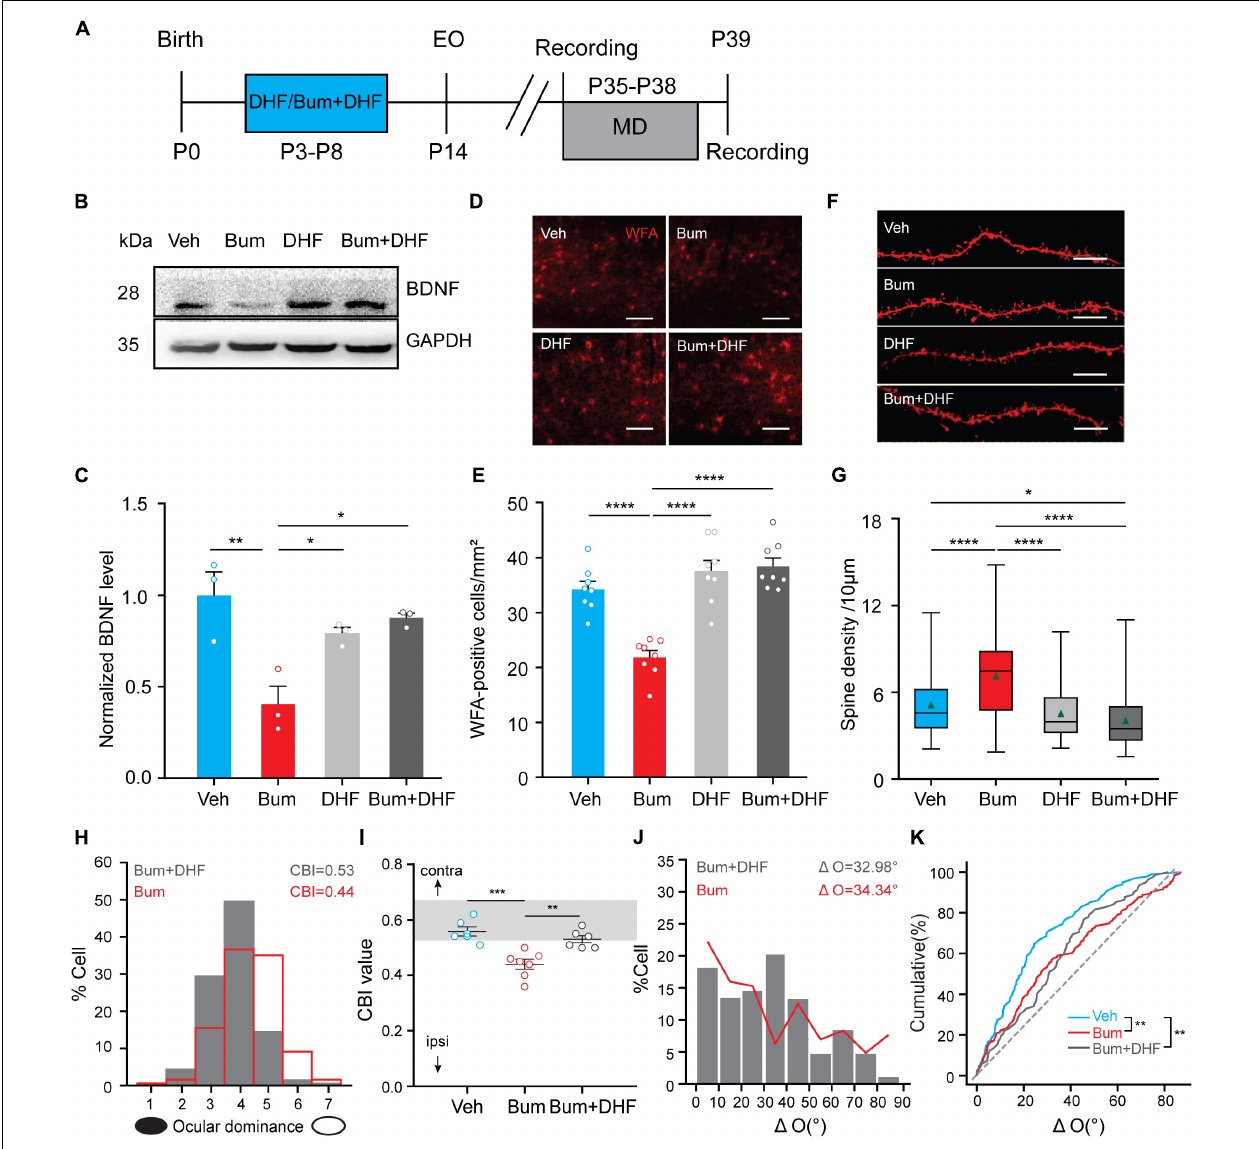
FIGURE 8 | Dihydroxyflavone (DHF) inhibits OD plasticity but does not rescue the binocular matching in Bum mice at P35. (A) Schematic graphic of the experimental protocol. (B,C) Cropped images and quantifications of immunoblotting for BDNF on protein extracts from P35 visual cortices of four groups (Veh, Bum, Bum + DHF, DHF). GAPDH was used as the internal standard ( p = 0.0045, Veh vs. Bum; p = 0.0171, Bum vs. DHF; p = 0.047, Bum vs. Bum + DHF, three mice per group; Mann-Whitney rank-sum test). Each circle indicates individual mouse. (D) Cropped images of WFA-stained perineuronal nets (red) in V1b at P35 in four groups (Veh, Bum, DHF and Bum + DHF)Scale bar, 200 µ m. (E) Quantification of density of WFA-positive cells in four groups. The density of positive cells in Bum mice is statistically lower than other groups ( p < 0.0001, eight mice per group, five sections per mouse, two mages per section; One-way ANOVA with Tukey’s post hoc test). (F) Representative images of DiI dye staining of lateral branches of apical dendrites at P35 in Veh and Bum, Bum + DHF and DHF mice. Scale bar, 10 µ m. (G) Spine density at P35 Bum (7.14/10 µ m) was significantly higher than age-matched Veh (5.14/10 µ m, 58 dendrites, four mice), Bum + DHF (4.05/10 µ m, 111 dendrites, five mice), DHF (4.53/10 µ m, 68 dendrites, four mice). The data are summarized by a box chart, and the horizontal lines in the box denote the 25th, 50th, and 75th percentile values. The error bars denote the 5th and 95th percentile values. The green triangle symbol indicates the average value. p = 0.0169, Veh vs. Bum + DHF; p < 0.0001, Veh vs. Bum; p < 0.0001, Bum vs. DHF; p < 0.0001, Bum vs. Bum + DHF. (H) DHF co-treatment with bumetanide (Bum + DHF) blocked the OD shift in Bum mice. The red solid line represents the OD distribution of Bum mice with 4 days MD. (I) OD plasticity quantified by the values of CBI (Veh: 0.56 ± 0.015, six mice; Bum + DHF: 0.53 ± 0.012, six mice; Bum: 0.44 ± 0.016, seven mice. p = 0.0002, Veh vs. Bum; p = 0.0028, Bum vs. Bum + DHF, One-way ANOVA with Tukey’s post hoc test). Open circles represent individual CBIs for each animal. (J) Distribution of the difference in orientation preference in Bum + DHF ( (cid:49) O = 32.98 ± 2.35 ◦ , 82 cells, 16 mice) and Bum ( (cid:49) O = 34.34 ± 2.15 ◦ , 142 cells, 14 mice) groups. (K) Cumulative distribution of (cid:49) O in Bum + DHF, Bum, and Veh ( (cid:49) O = 24.26 ± 1.54 ◦ , 102 cells, nine mice; p = 0.0035, Veh vs. Bum; p = 0.0031, Veh vs. Bum + DHF; p = 0.929, Bum + DHF vs. Bum, K-S test). P35 for binocular matching; P35 + 4d MD for ocular dominance plasticity. DHF, light gray; Bum + DHF, dark gray. Data were expressed as mean ± SEM except for box charts. * p < 0.05, ** p < 0.01, *** p < 0.001, **** p < 0.0001.